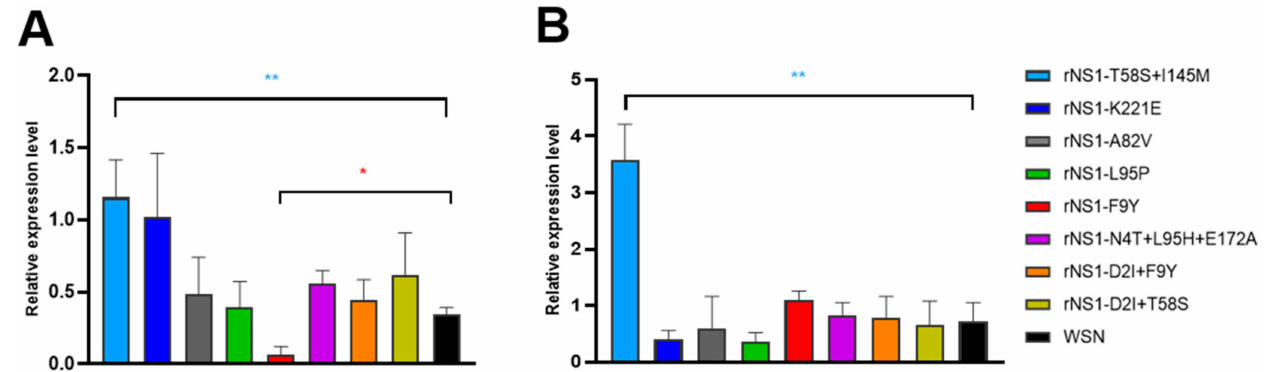
Figure 4. The relative mRNA expression levels of IFN induced by rNS1 mutants and WSN viruses in mice. ( A ) Lungs were collected at 3 dpi ( B ) and 5 dpi for IFN β mRNA detection by qPCR. Expression levels were normalized to that of GAPDH and are presented as changes (n-fold) in induction relative to the control value. p values were calculated by using the Student’s t -test, * p < 0.05, ** p <